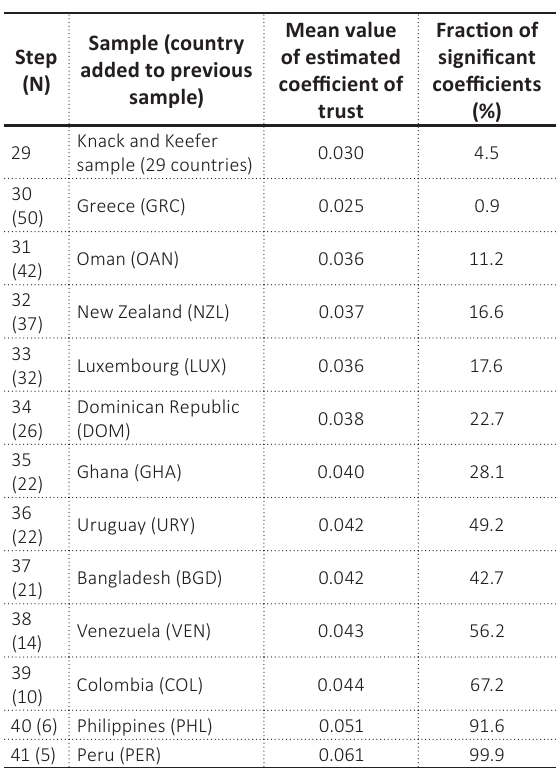
Table 1. Effects of the composition of the sample on trust using EBA